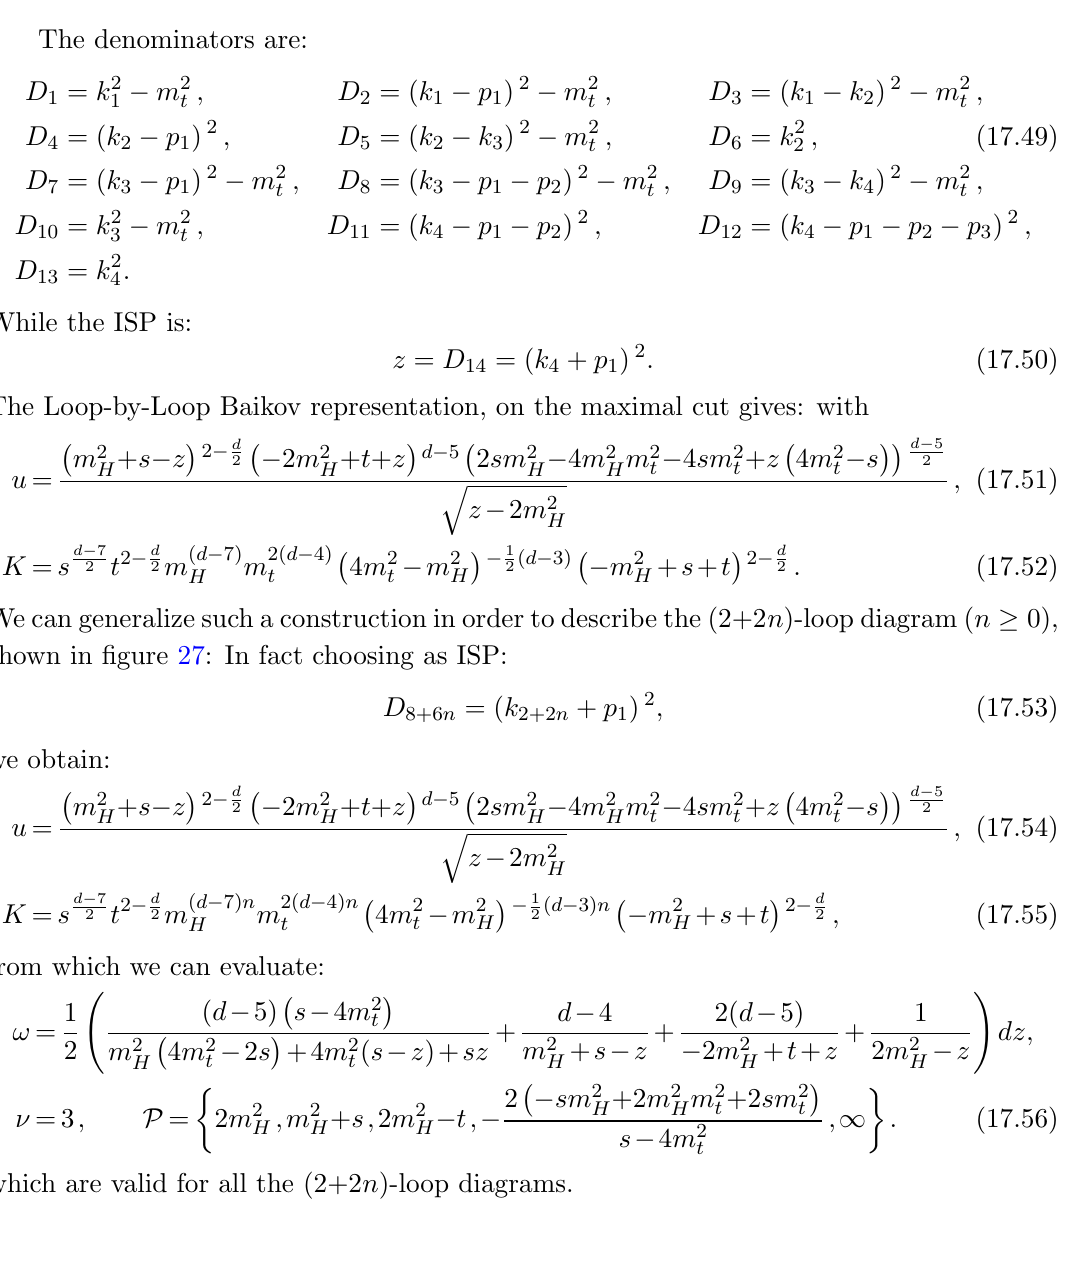
Figure 26. Planar four-loop diagram contributing to H + j